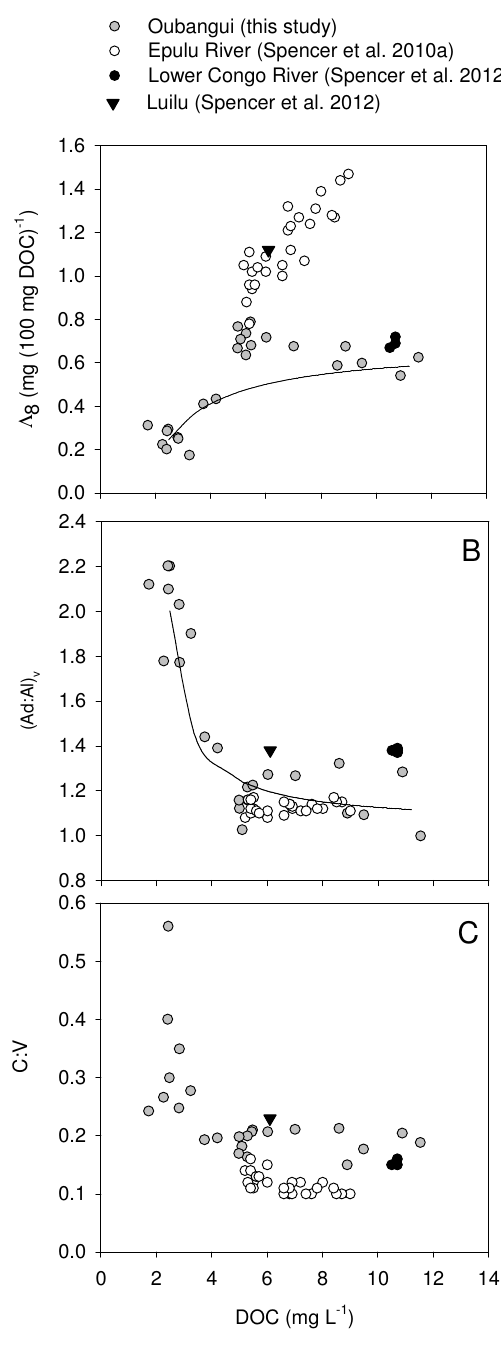
Fig. 11. Covariation between dissolved organic carbon concentra- tions and (A) carbon-normalized lignin yields ( 3 8 ) , (B) (Ad:Al) v ratios, and (C) C:V ratios, for the Oubangui River at Bangui be- tween March 2010 and March 2011 (grey symbols), along with lit- erature data from other locations in the Congo River basin (open and black symbols, see legend). Lines on (A) and (B) show a theoretical two end-member mixing scenario (see text for